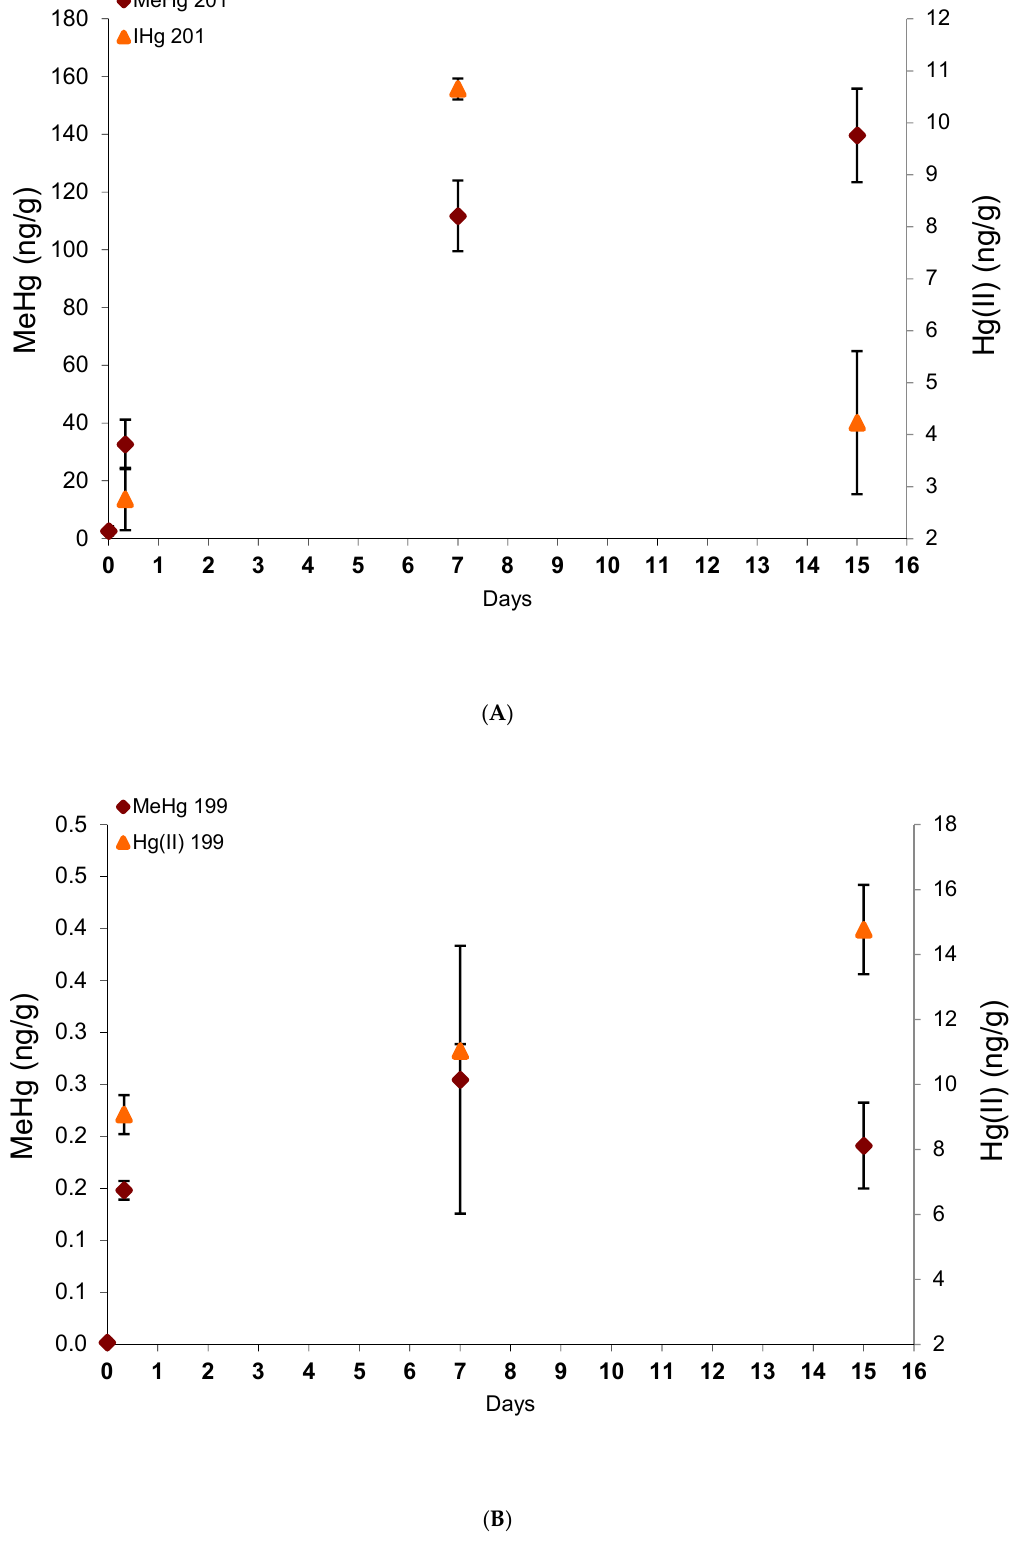
Figure 2. Exogenous mercury species concentrations derived from the spiked Me 201 Hg ( A ) and 199 Hg(II) ( B ) with time.